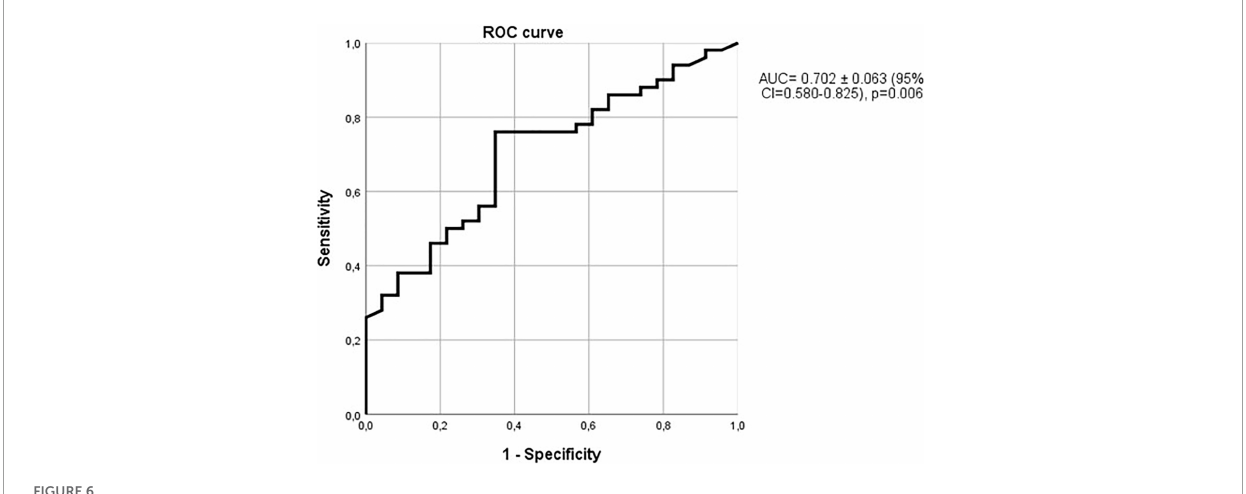
FIGURE6 Relationship of sclerostin with vascular calcifications in non-hypertensive patients. ROC curve with an AUC = 0.702 ± 0.063 (95% CI = 0.580–0.825), p = 0.006.